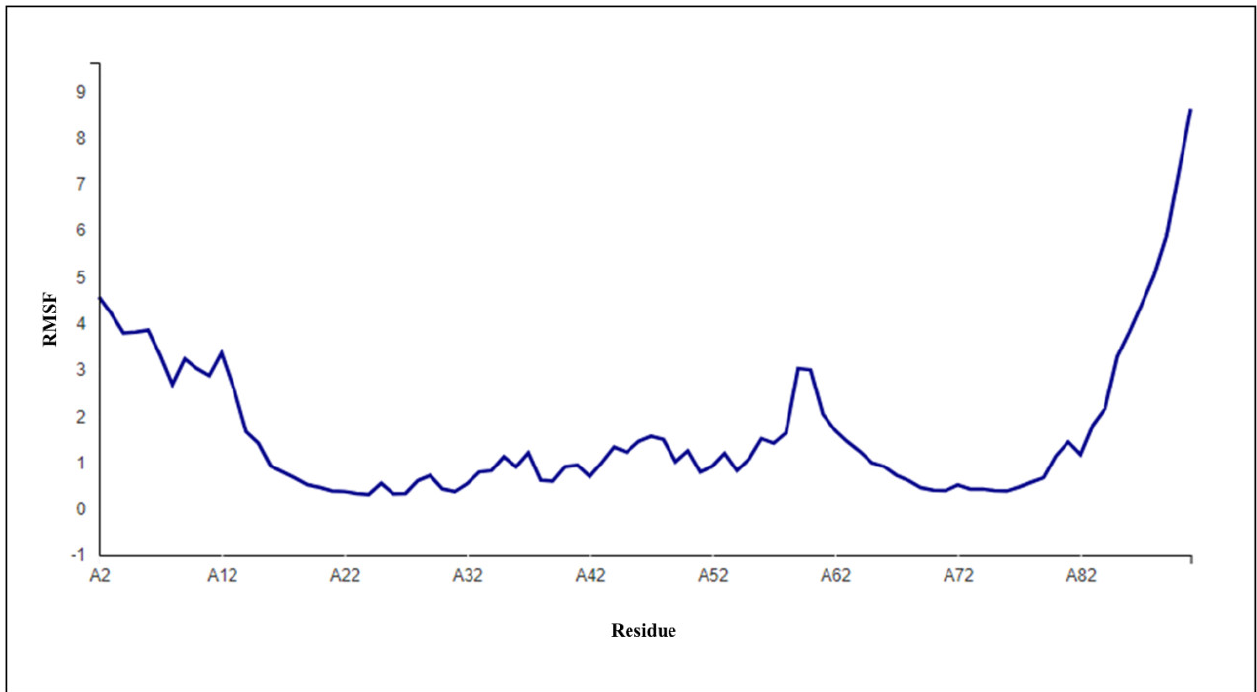
Figure 5. Root-mean-square fluctuation (RSMF) plot of the simulated DLC1 structure. To check the refinement status, we aligned both structures before and after the molec- ular dynamics simulation structures of DLC1. Figure 6 represents the aligned structure with the non-aligned residual segments. After the alignment, we observed that the DLC1, before the simulation analysis, had longer loops and helices. Some residues that formed the main loop present in the DLC1 (before the simulation), starting from residues 1–15 (GSSGSSGMCRKKPDT), seemed to have been shortened in the refined structure, as this region did not align with the refined structure of the DLC1. Another loop region, starting from residues 85–91 (ESGPSSG), tended to have folded on the upper hand, which was different from the original DLC1 (refer to Figure 6). Also, a short region helix, starting from residues 39–44 (AQLYEDF), turned into a loop in the refined structure, unlike a complete helix, as observed in the original DLC1 protein structure. It is evident that the folding of the loops changed as refinement. This could be possible because of the electrostatic potential that has been known to enhance the protein folding and binding potential of proteins